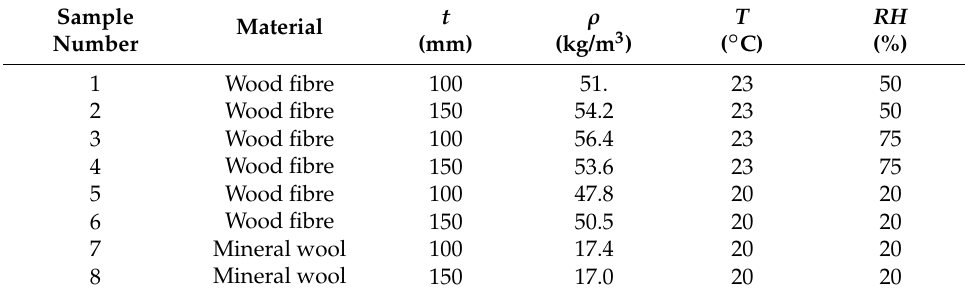
Table 1. Material specimen properties and test conditions for the thermal conductivity measurements. t , state the thickness of the insulation batten in mm, ρ state the measured density of the different specimen in (kg/m 3 ), T states the temperature ( ◦ C) and RH (%) states the relative humidity of the room where the samples were stored before